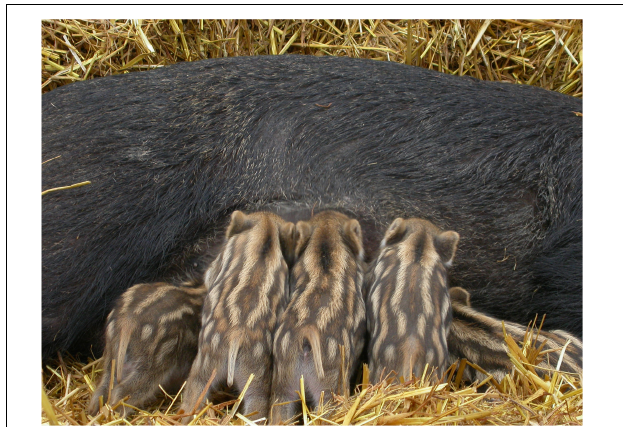
FIGURE 1 | Wild boar sow with piglets. The piglets show the characteristic camouflage pattern which requires the presence of a wild-type MC1R allele. Photo: Annelie